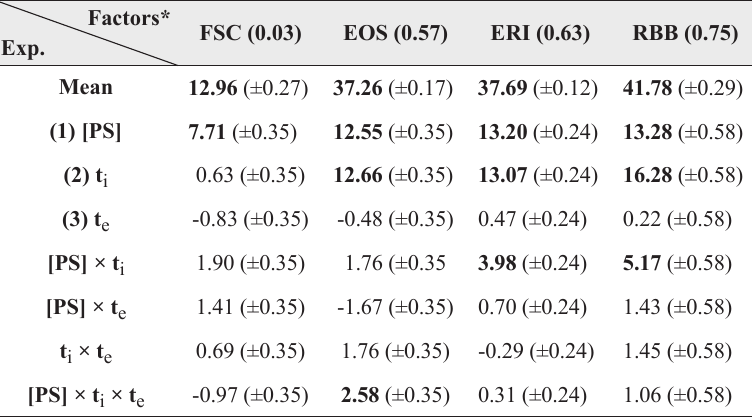
Effects calculated for the photodynamic activity with the photosensitizers based on 2 3 factorial design. Some high values are